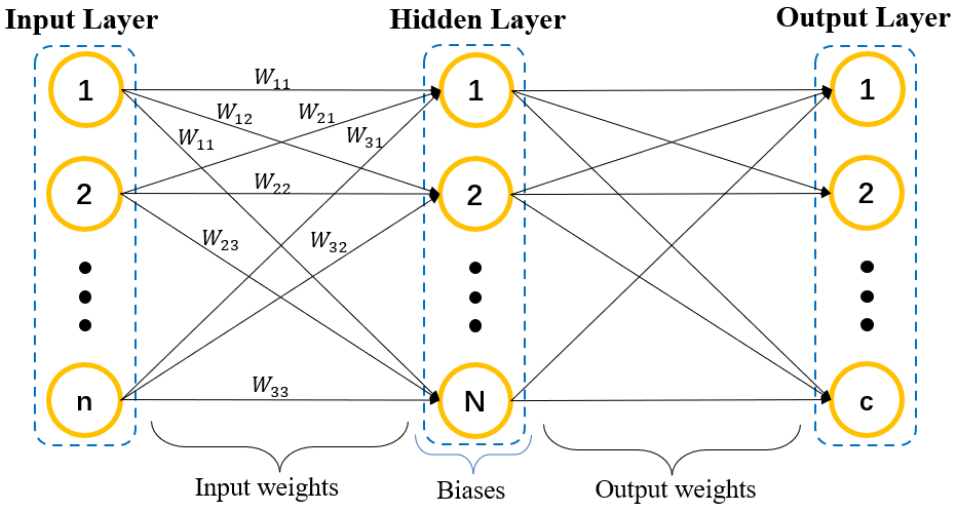
Figure 1. The structure of the ELM